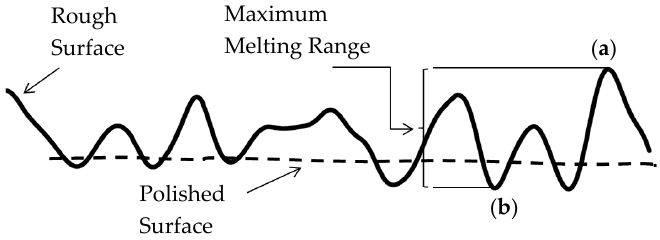
Figure 2. The principle used in the laser polishing process by melting the metal between ( a ) and ( b ) [37].